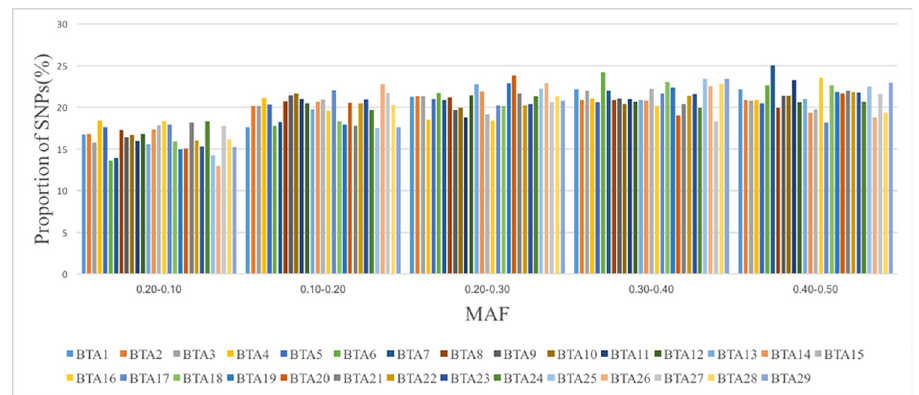
Fig 1. Mean proportion of SNPs for various minor allele frequencies (MAF) calculated for each autosomal chromosome.